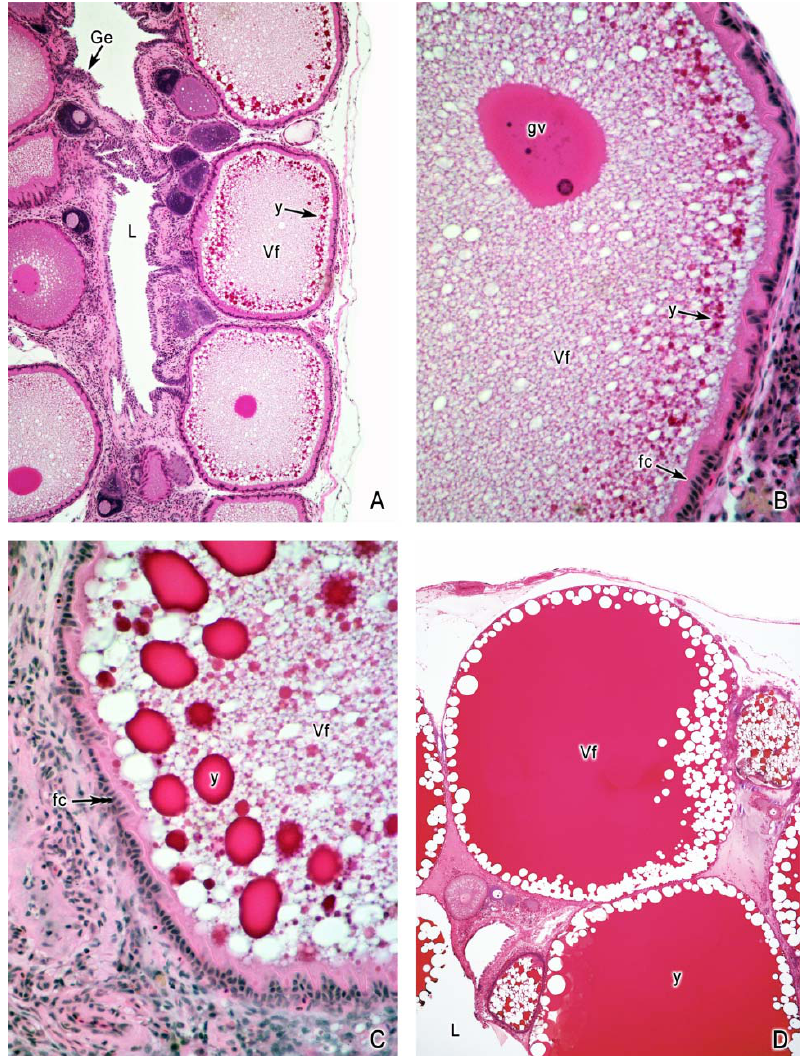
Figure 4. Morphology of the germinal cells during oogenesis. Follicles during vitellogenesis (Vf). ( A ) Oocytes of Poecilia reticulata at the initiation of vitellogenesis (Vf), with the deposition of yolk globules (y) in the ooplasm. The germinal epithelium (Ge) borders the ovarian lumen (L). 32×. ( B ) Detail of the figure A, where the fine yolk globules (y) are seen at the ooplasmic periphery. The follicular cells (fc) are seen around the oocyte. 200×. ( C ) Peripheral ooplasm of an oocyte of Poecilia reticulata at the advance of vitellogenesis (Vf), with larger yolk globules (y) than those seen in the previous figure. 500×. ( D ) Maximum size of an oocyte of Gambusia affinis ; the yolk (y) is fluid and homogeneous; some lipid droplets may be seen around the oocyte periphery. Ovarian lumen (L). 20×.